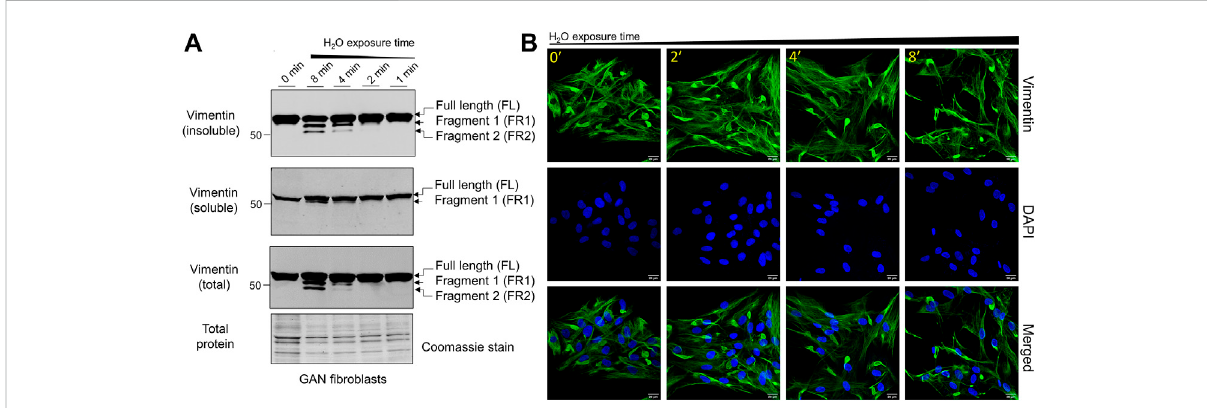
FIGURE 1 Hypotonic stress induces time-dependent cleavage and reorganization of vimentin IFs in GAN fi broblasts. (A) Immunoblotting of vimentin in reduced Triton X insoluble pellet fractions (top), Triton X soluble fractions (middle), and total cell lysates (bottom) from GAN fi broblasts (GAO1B) exposed to hypotonic stress conditions (sterile molecular grade H 2 O) for 0 – 8 min. Only full length (FL) vimentin is present in the 0-min condition (lane 1), but a time-dependent, osmotic stress-induced increase in vimentin cleavage is observed starting in the 2-min condition (lane 4). The two vimentin fragments (FR1, FR2) produced are most abundant in the 8-min condition (lane 2). Coomassie stain was used as a control for total protein. (B) Immuno fl uorescence analysis of GAN fi broblasts (B16.64) stained with vimentin (green) and DAPI (blue) after exposure to water for 0 – 8 min; scale bar = 20 μ m. Note the persistence of vimentin aggregates, but a reduction in vimentin fi